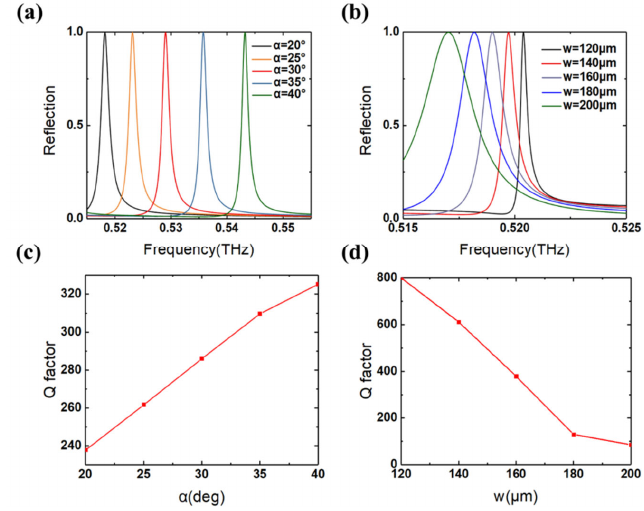
Figure 2. Effects of terahertz wave incident angles and unit cell structure parameters on the reflection spectrum and Q value change. ( a , c ) α = 20–40°; ( b , d ) w = 120–200 µm.